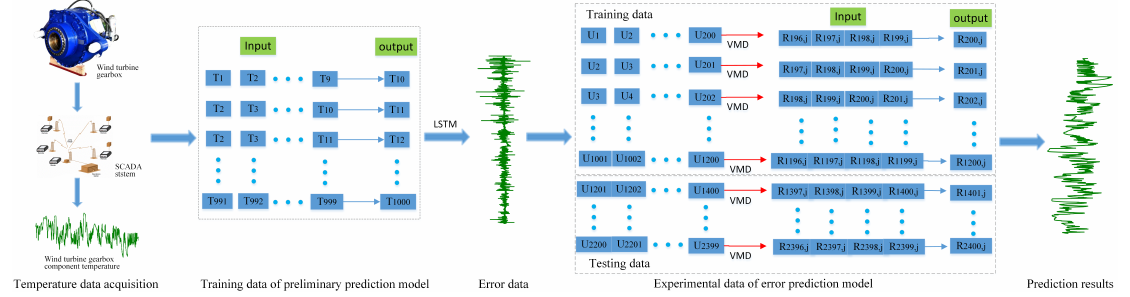
Figure 2. The construction process of modeling data for temperature prediction